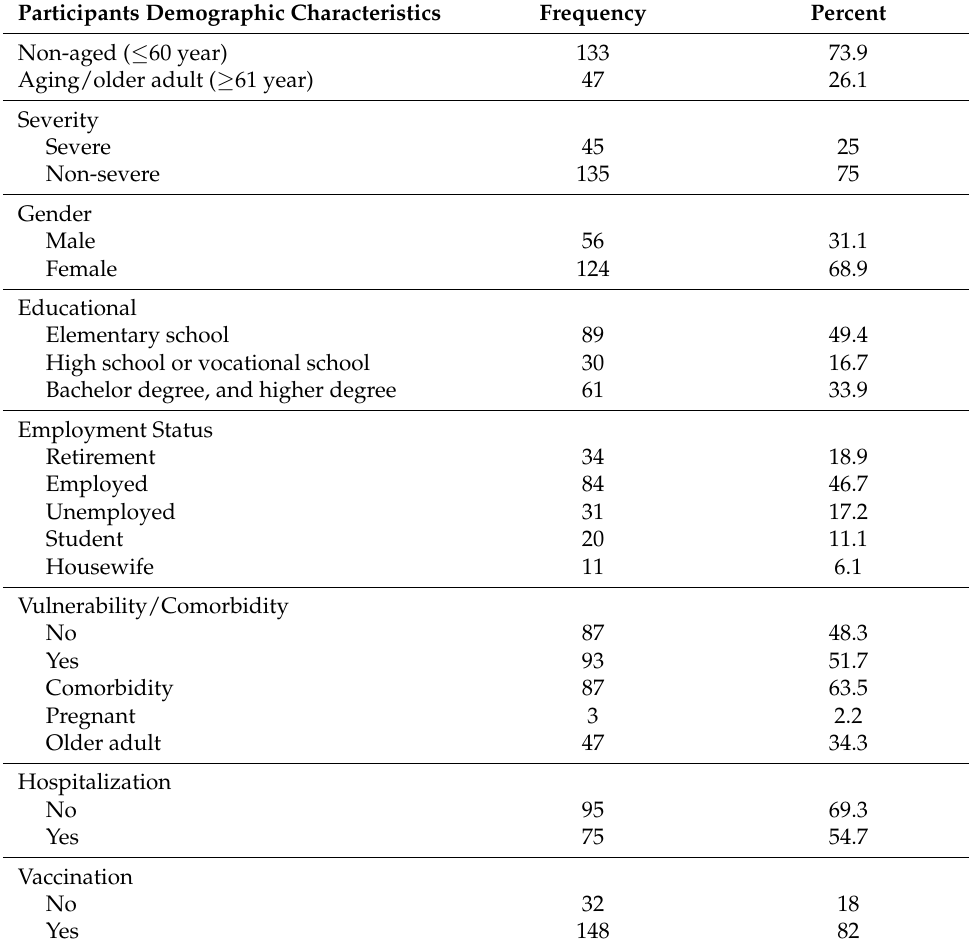
Table 1. Participants demographic